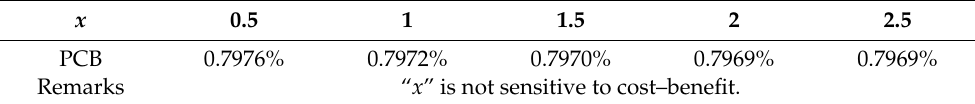
Table 7. Sensitivity of “ x ” to cost–benefit. The static input values of the parameters are: P = 5000,